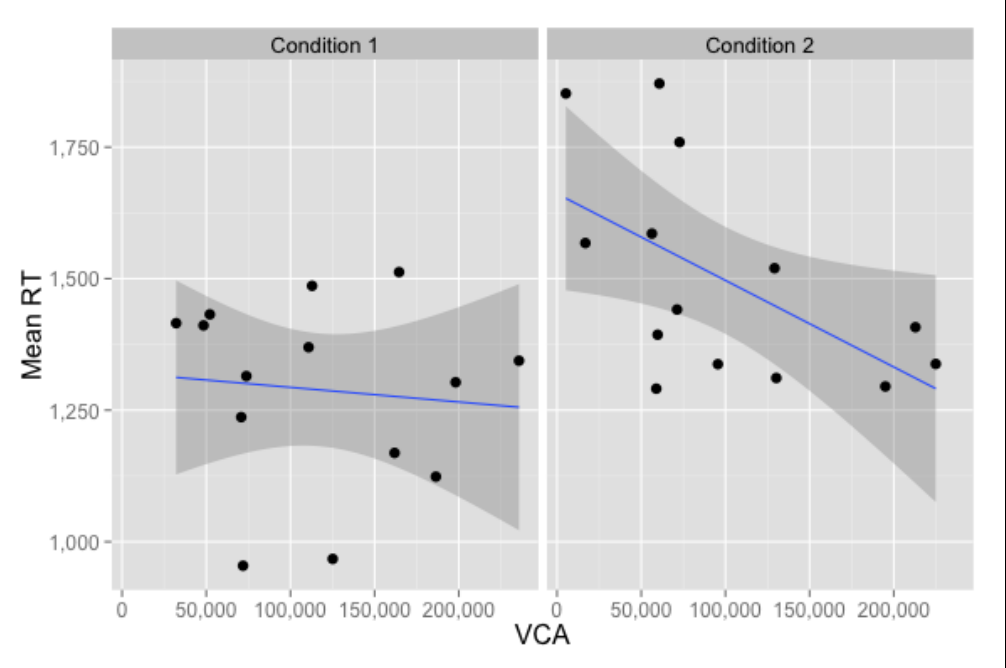
Figure 9. Location-based correlations for Mean Reaction Time and Visibility Catchment Area (VCA). Data points represent